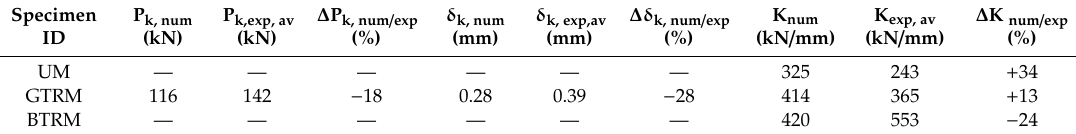
Table 14. Numerical results (knee load, knee displacement, sti ff ness) and comparison with the experimental values.